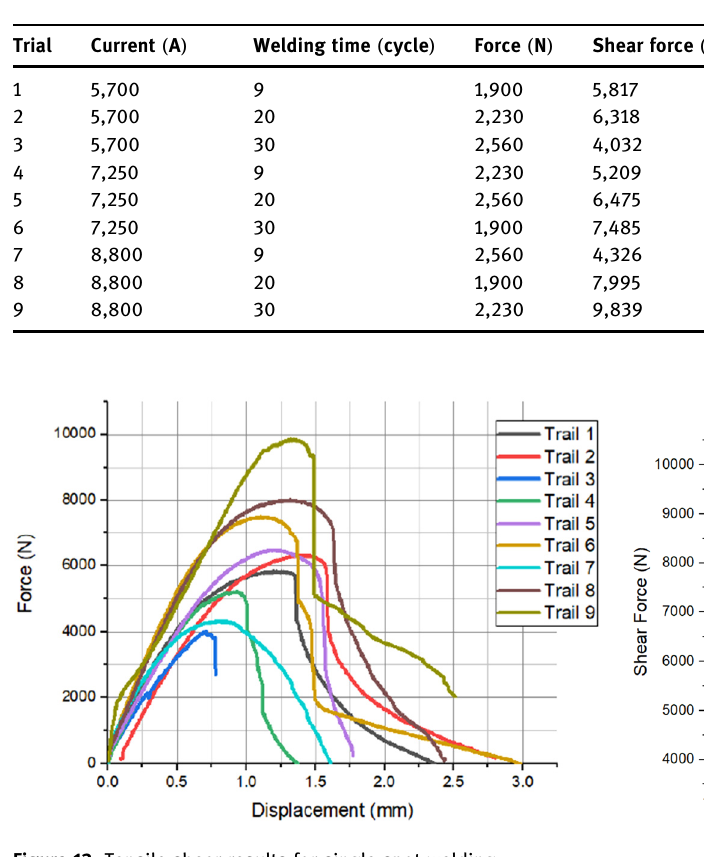
Figure 14: Shear force vs absorbed energy.